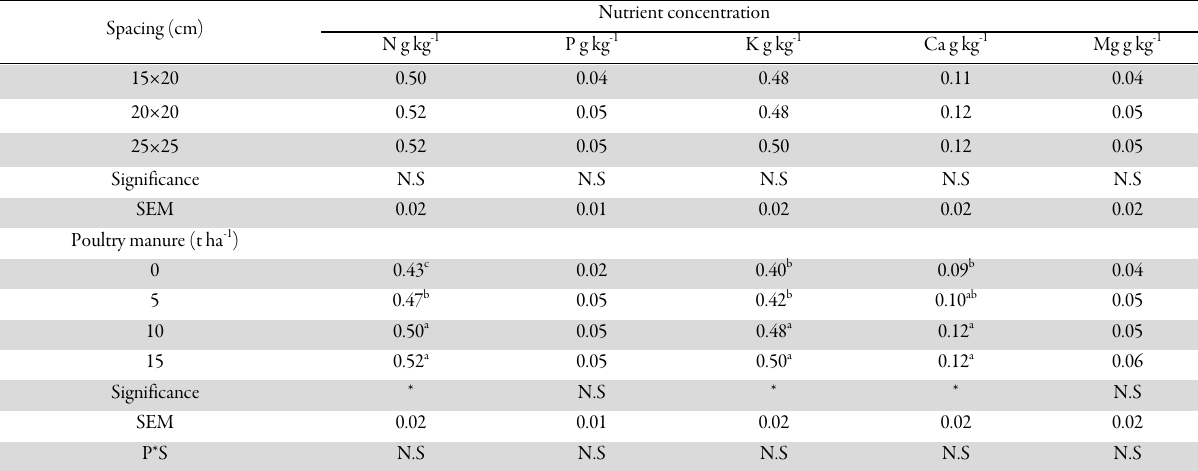
Table 5. Effect of poultry manure and spacing on nutrient concentration of onion